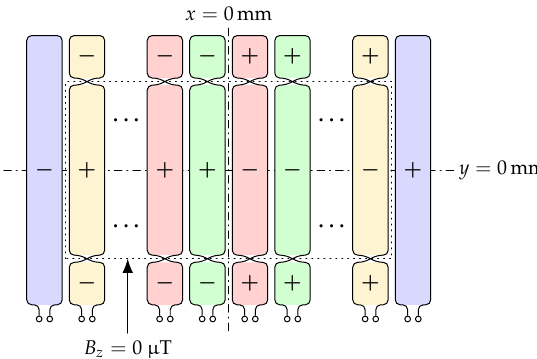
Figure 18. Improvement of the detectability of foreign objects in areas where the decisive component of the magnetic field, in this case the z -component, takes the value zero—the signs symbolize the orientation of the conductor loops, the colors the different sensor